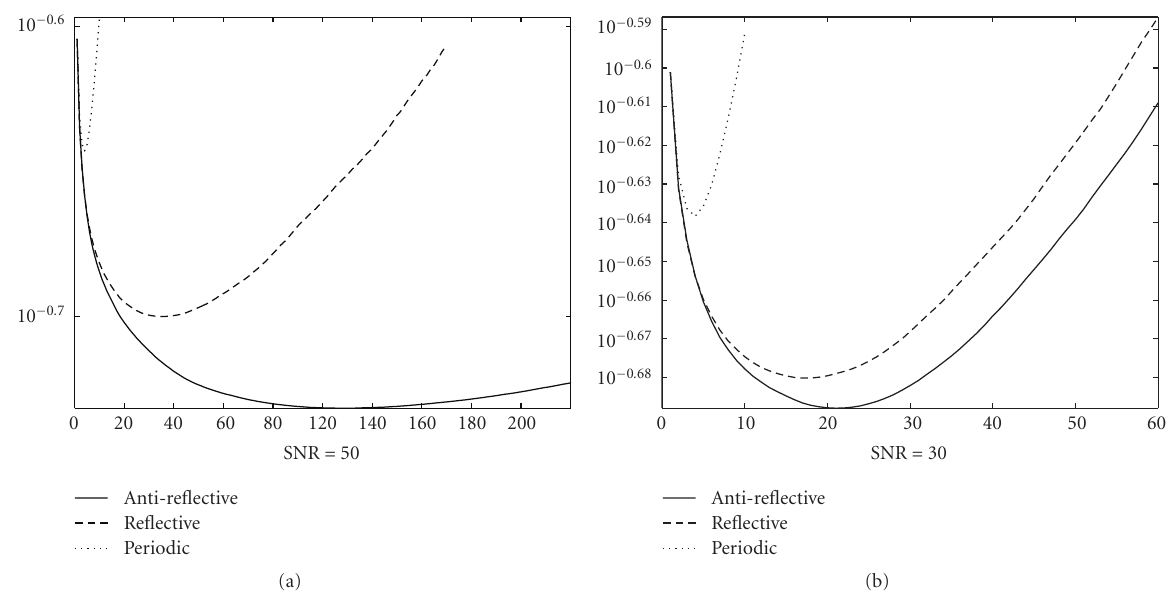
Figure 7: Test I: RREs at each CG iteration with di ff erent BCs: dotted line: Periodic, dashed line: Reflective, solid line: